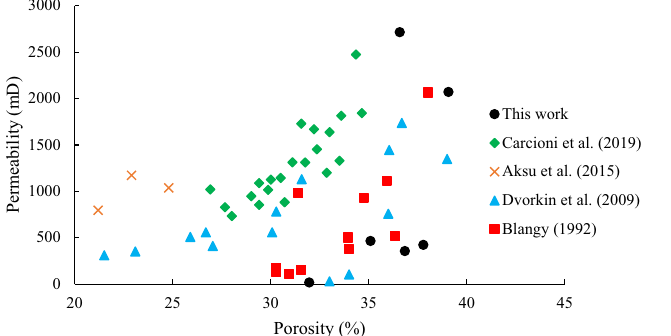
Figure 6. Comparison between rock porosity and permeability of this work and the literature (data from 41,74– 76